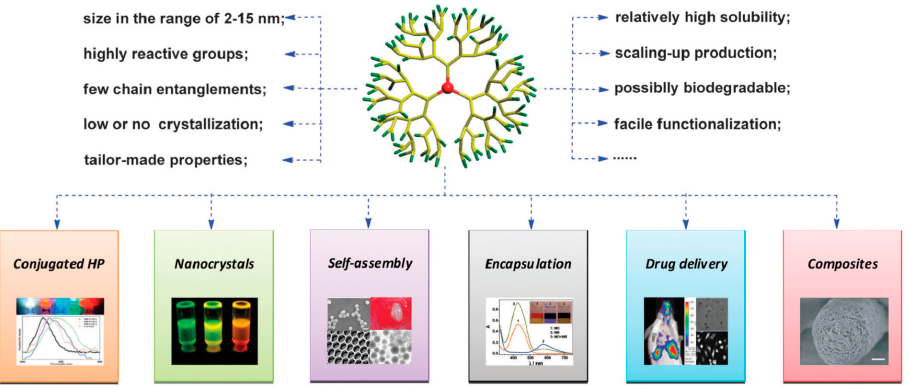
Figure 3. Relationship between the structure and properties of HMs and their major